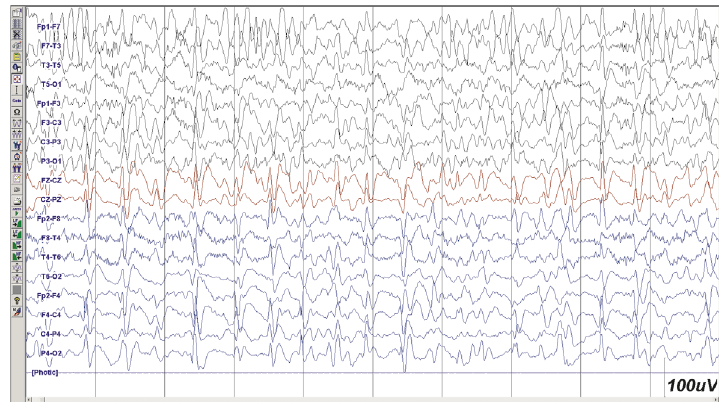
Figure 1: The initial EEG showed pseudoperiodic lateralized epileptiform discharges over the right hemisphere with a frequency of 2–3 Hz. Calibration: 1 s between vertical lines and 100 𝜇 V per vertical unit. Low filter: 1 Hz; high filter: 35 Hz; notch filter: 50 Hz.